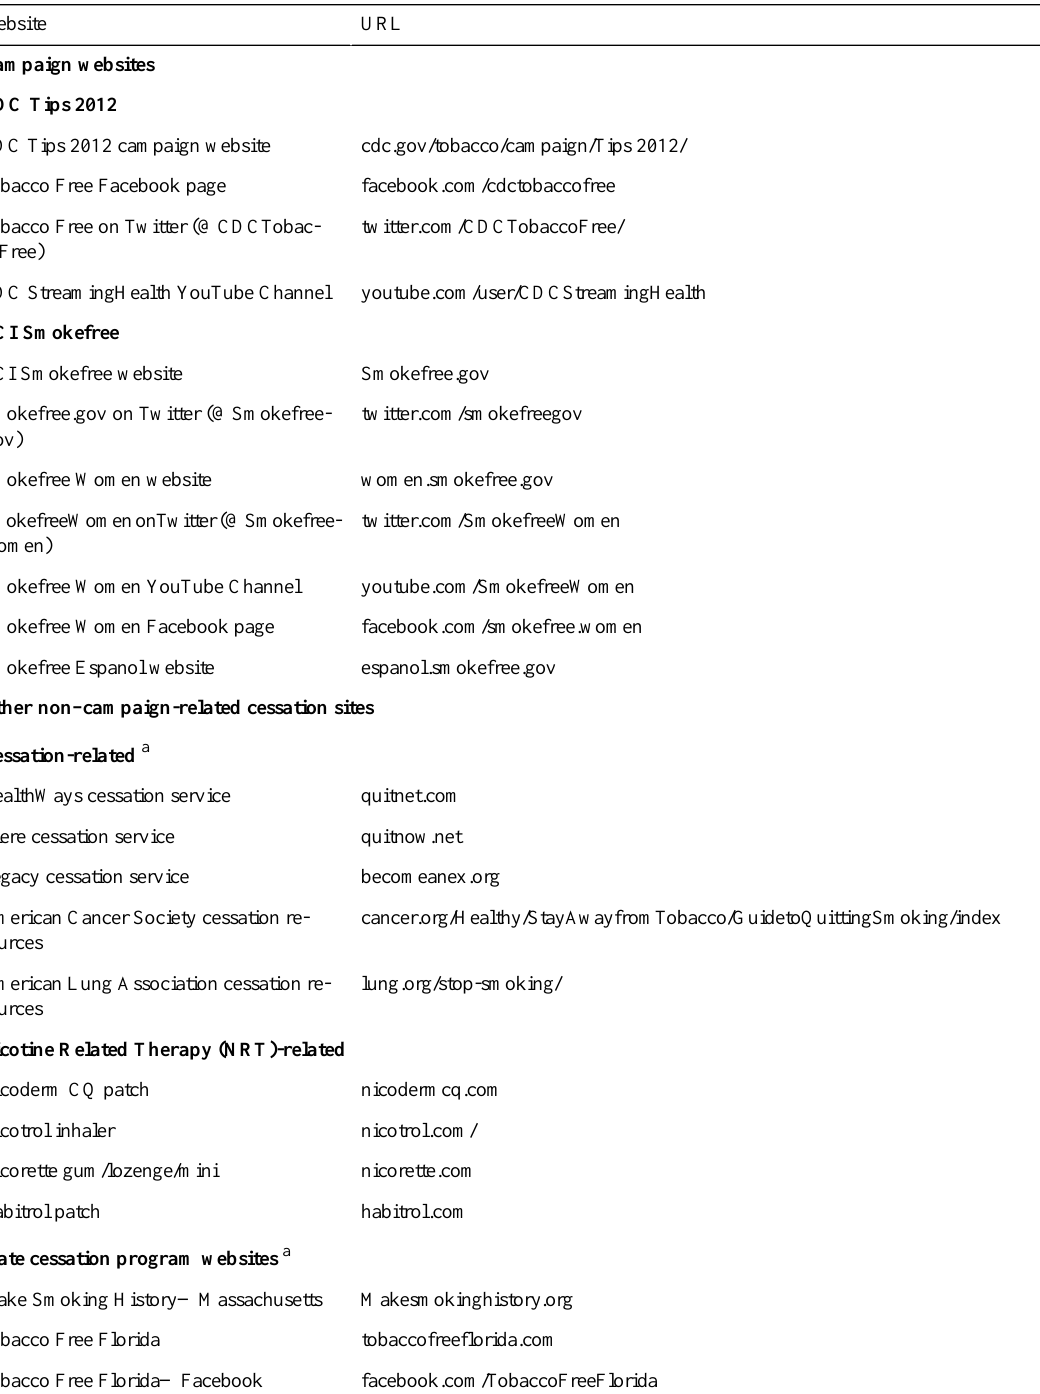
Table 2. Tips 2012 campaign and non-campaign